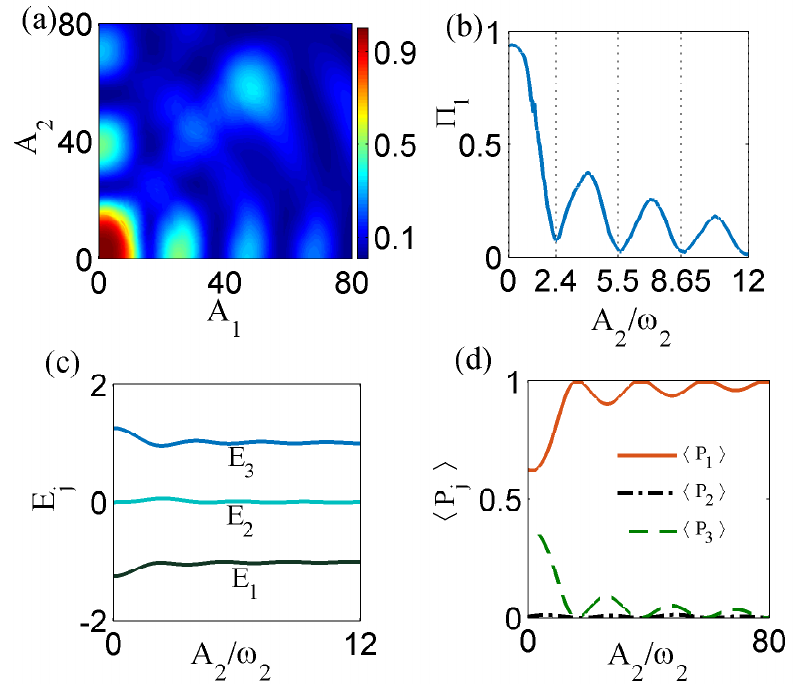
Figure 6. (Color online) ( a ) Evolution of Π 1 as a function of A 1 and A 2 and such a 2/3rd − photon resonance effect shows a clear dependence on driving amplitudes. ( b ) Evolution of Π 1 versus A 2 / ω 2 for A 1 = 10. The minimum values of Π 1 are coincide with zeros of J 0 ( A 2 / ω 2 ) . ( c ) Quasienergies E j versus A 2 / ω 2 and ( d ) Time-averaged population (cid:104) P j (cid:105) corresponding to the medium quasienergies E 2 . Other parameters are chosen as ω 1 = 10, ω 2 = 20/3 and φ =